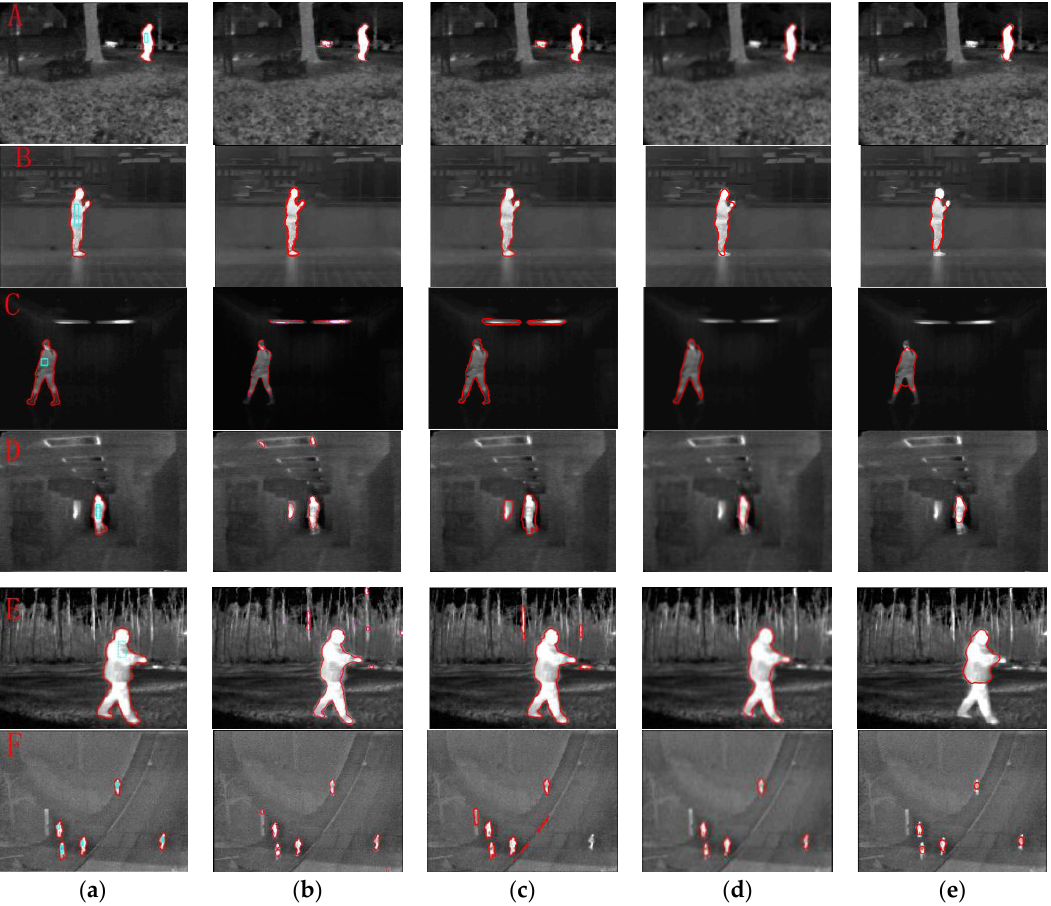
Figure 7. Segmentation results. From left to right ( a ) The proposed method IALSE (rectangle stands for the initial curve); ( b ) FCMLSM; ( c ) LSACM; ( d ) Robust_ESF; ( e ) DRLSE.